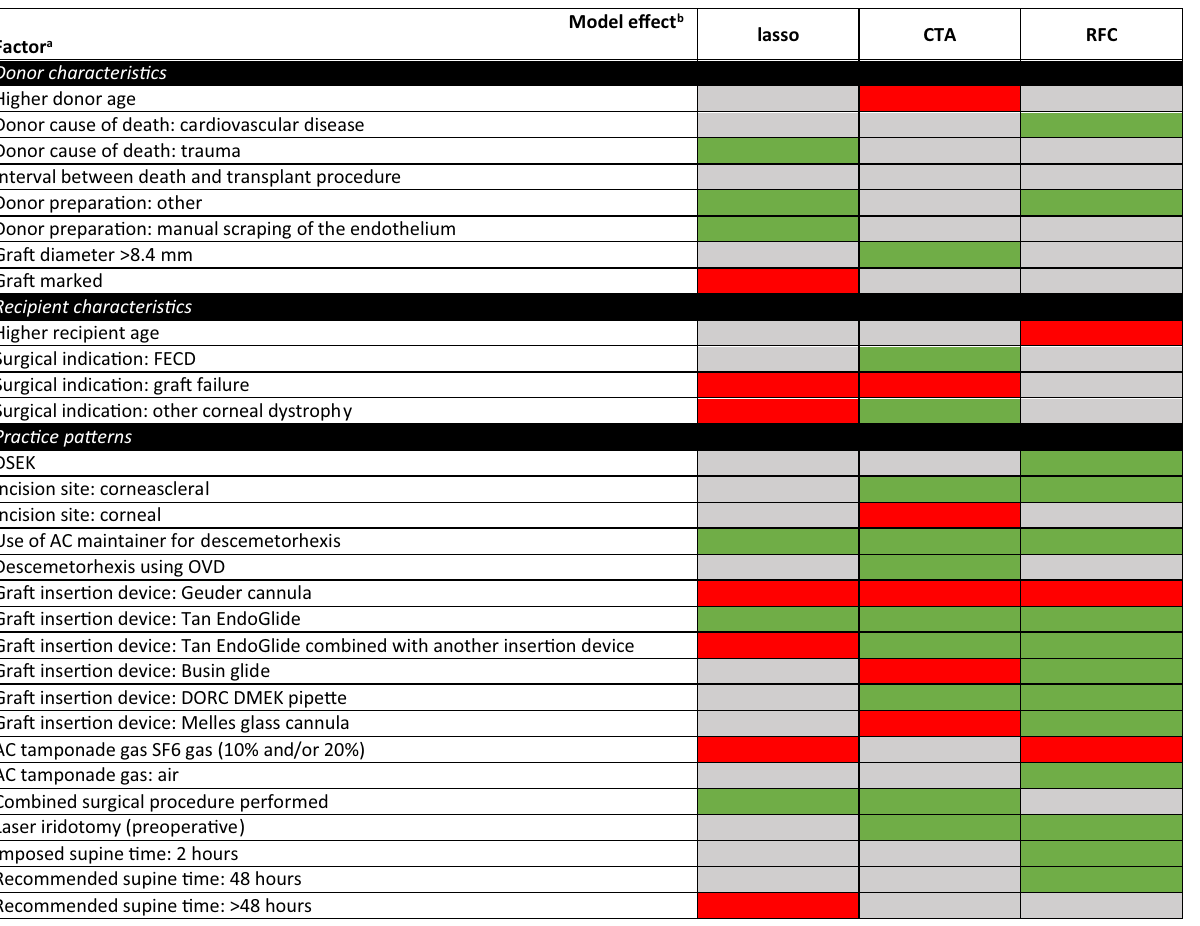
Table 3. Overview of the most relevant factors and their effect identified by the three machine learning models (green: reduced risk, red: increased risk, light grey: unclear). AC anterior chamber, CTA classification tree forest classification, SF6 sulfur hexafluoride. a Factors with the category “unknown” or “unspecified” have been omitted. b Green: reduced risk of detachment; red: increased risk of detachment; light grey: unclear (either diffuse pattern or not identified by the